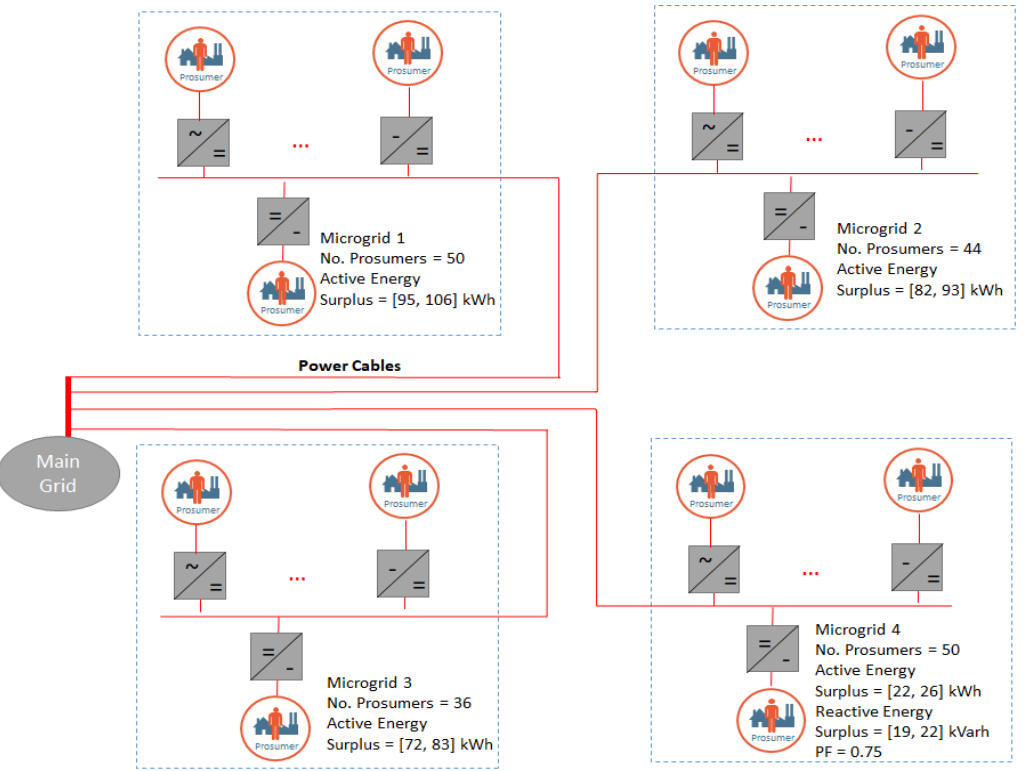
Figure 4. The scenario considered for simulation. Table 1. Experimental setup for prosumers generation.